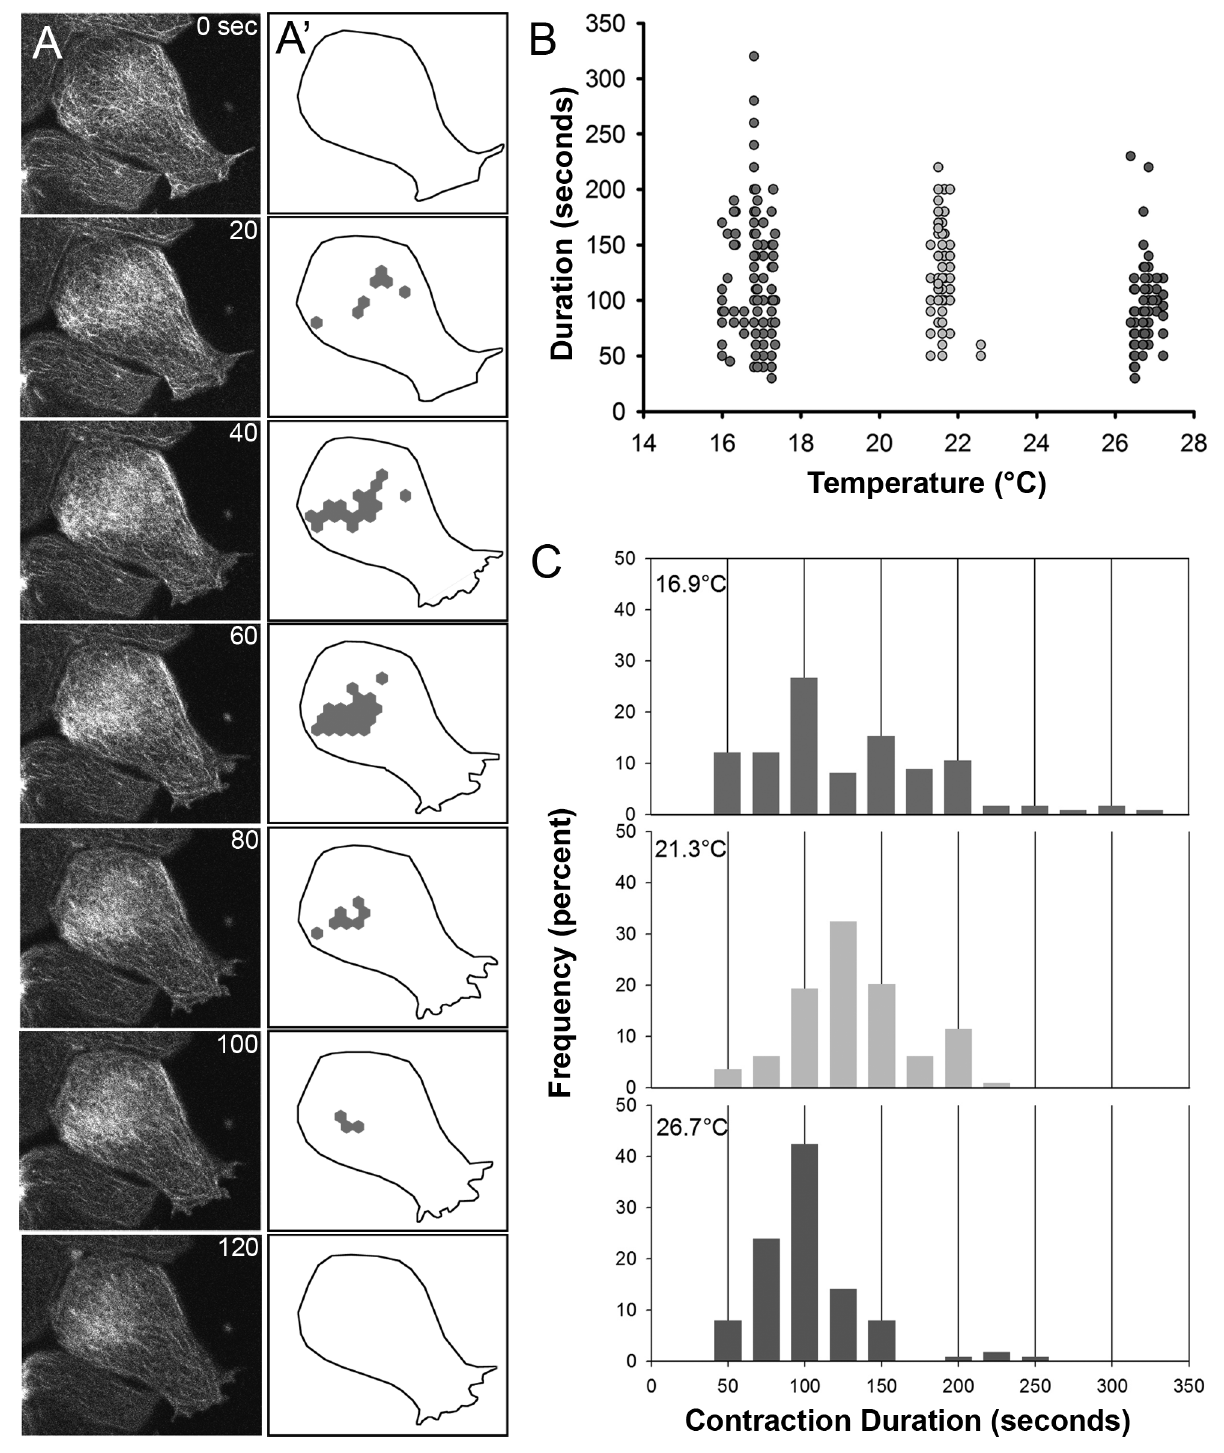
Figure 4. Duration of actomyosin contractions depends on temperature. (A) Sequential frames from a representative time-lapse sequence collected from the basal cortex of an animal cap ectoderm explant cultured on fibronectin-coated glass substrate. F-actin dynamics are revealed in cells expressing the actin-binding domain from moesin coupled to EGFP (moe-GFP) (left column). This sample collected at 16 u C. (A 9 ) Schematic of frames matching those in (A) highlighting the cell outline (dotted line) and hexagonal regions of the cell cortex identified as ‘‘F-actin contractions.’’ Regions are categorized as contractions when their integrated intensities are 50% greater than the mean intensity of the basal cell cortex. (B) Duration of individual F-actin contractions across the three temperature regimes. (C) Frequency distribution of the duration F-actin contractions at three temperatures. Note abundant short duration contractions at the low temperature regime.